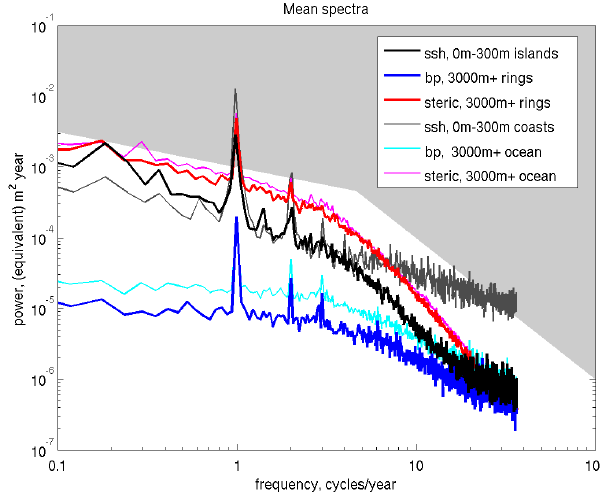
Fig. 2. Mean spectra of shallow-water sea-surface height ( h ) (black/grey), and deep-water steric ( φ ) (red) or bottom pressure ( p ) (blue) contributions to sea-surface height. Heavy curves are for spectra averaged over islands ( h ) or surrounding deep rings ( φ,p ). Lighter curves are for continental shelves ( h ) or deep water open ocean ( φ,p ). Polar regions are excluded. Background shading indi- cates power proportional to σ − 1 / 2 and σ − 2